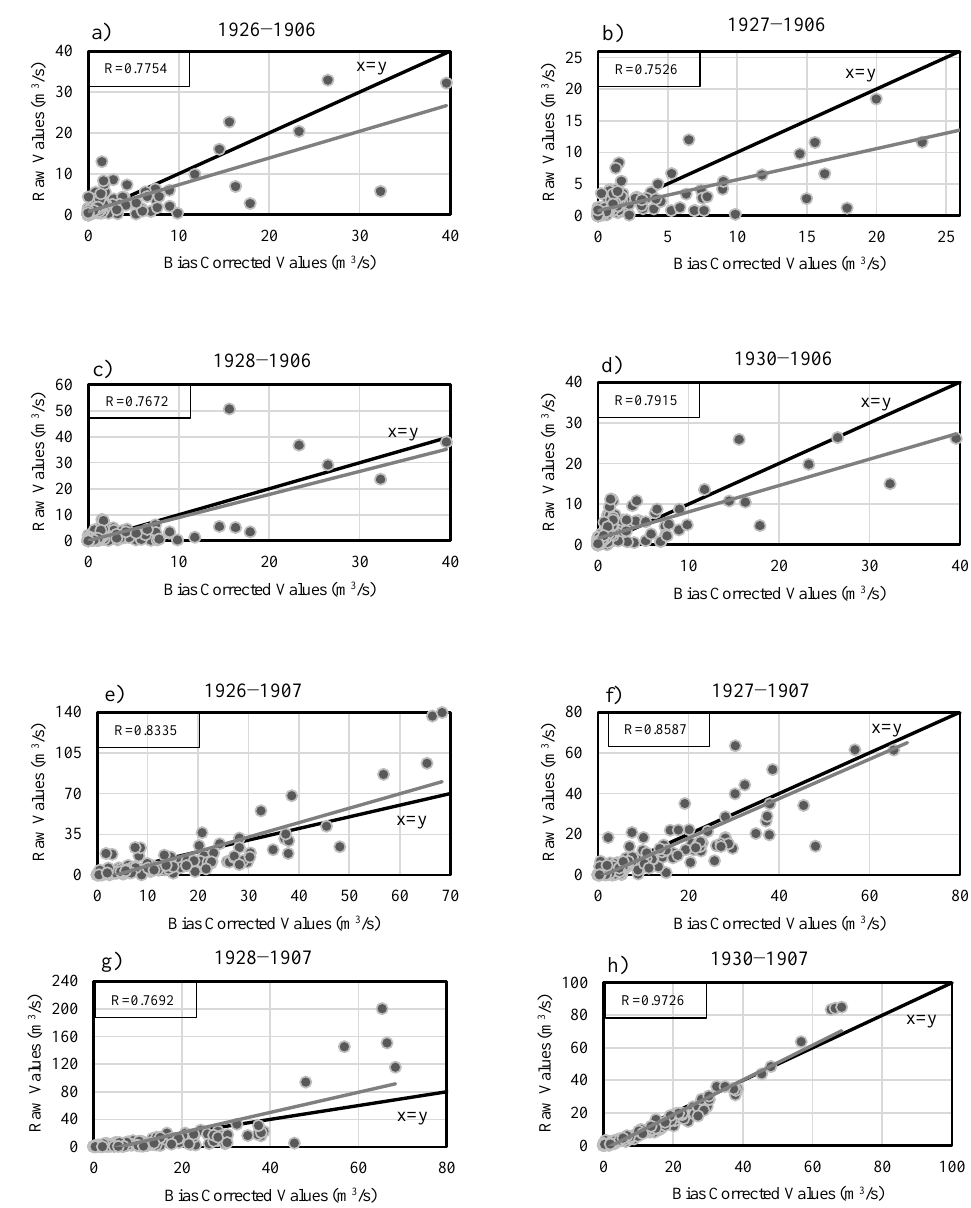
Figure 6. Correlation plot between the original and bias-corrected values for the number 1906 and 1907 SGSs. ( a ) 1926 to 1906, ( b ) 1927 to 1906, ( c ) 1928 to 1906, ( d ) 1930 to 1906, ( e ) 1926 to 1907, ( f )1927 to 1907, ( g ) 1928 to 1907, ( h ) 1930 to 1907. Linear regression line represented with grey, x=y graph represented with black colored line.